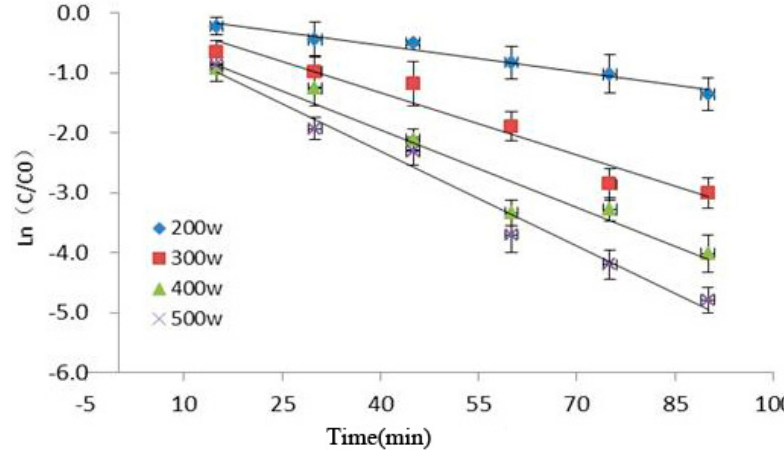
Figure 3. Kinetics analysis of Cy-3-glu after power ultrasound ( n = 3). Table. 1. Kinetics parameters of Cy-3-glu degradation exposed to ultrasonic wave.